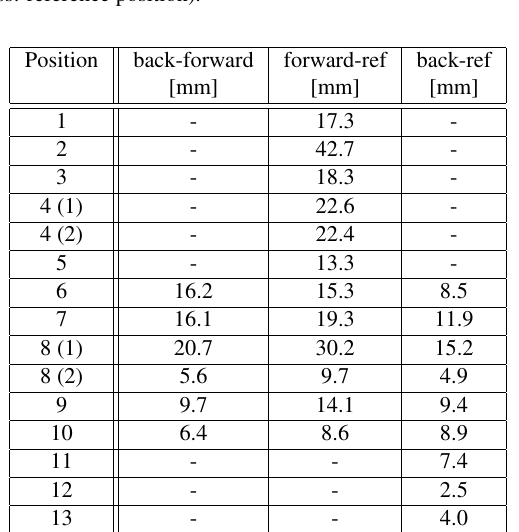
Figure 6: Deviation of calculated positions based on different scans. Different colors show different scanner orientations (black cross: reference position).